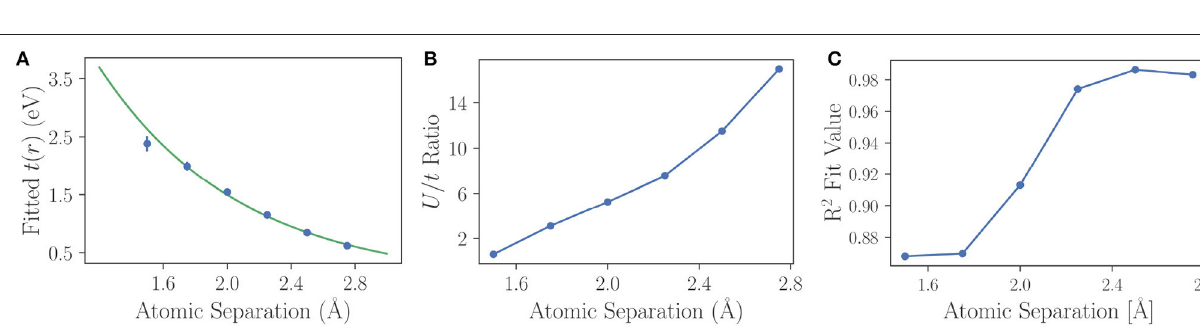
FIGURE 7 | Reconstructed model energy ( E eff [ ψ ]) vs. DMC energy ( E [ ψ ]) for the H 10 chain at (A) 1.5 Å and (B) 2.25 Å . The energy range of excitations narrows significantly for larger interatomic separation. Insets show the intrinsic atomic orbitals which constitute the one-body space which was used for calculating the reduced density matrices (descriptors).